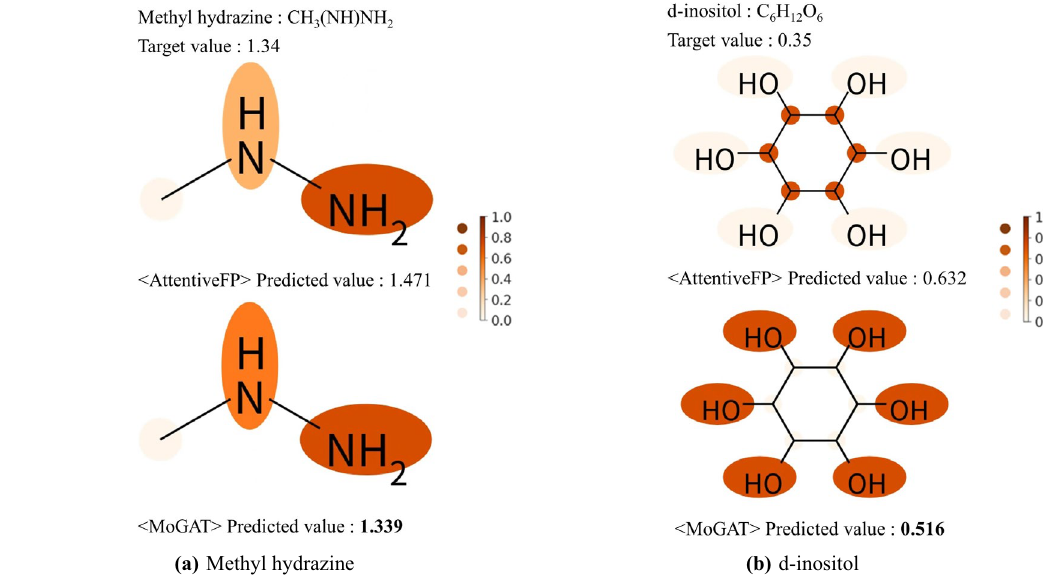
Figure 3. Relative importances of chemical components in computing water solubility predicted by AttentiveFP and MoGAT, for ( a ) methyl hydrazine and ( b ) d-inositol. The predicted water solubility values (unit: logS) are also provided for both AttentiveFP and MoGAT with experimentally measured values (target values). The attention scores are illustrated by the color-coding shown in the right